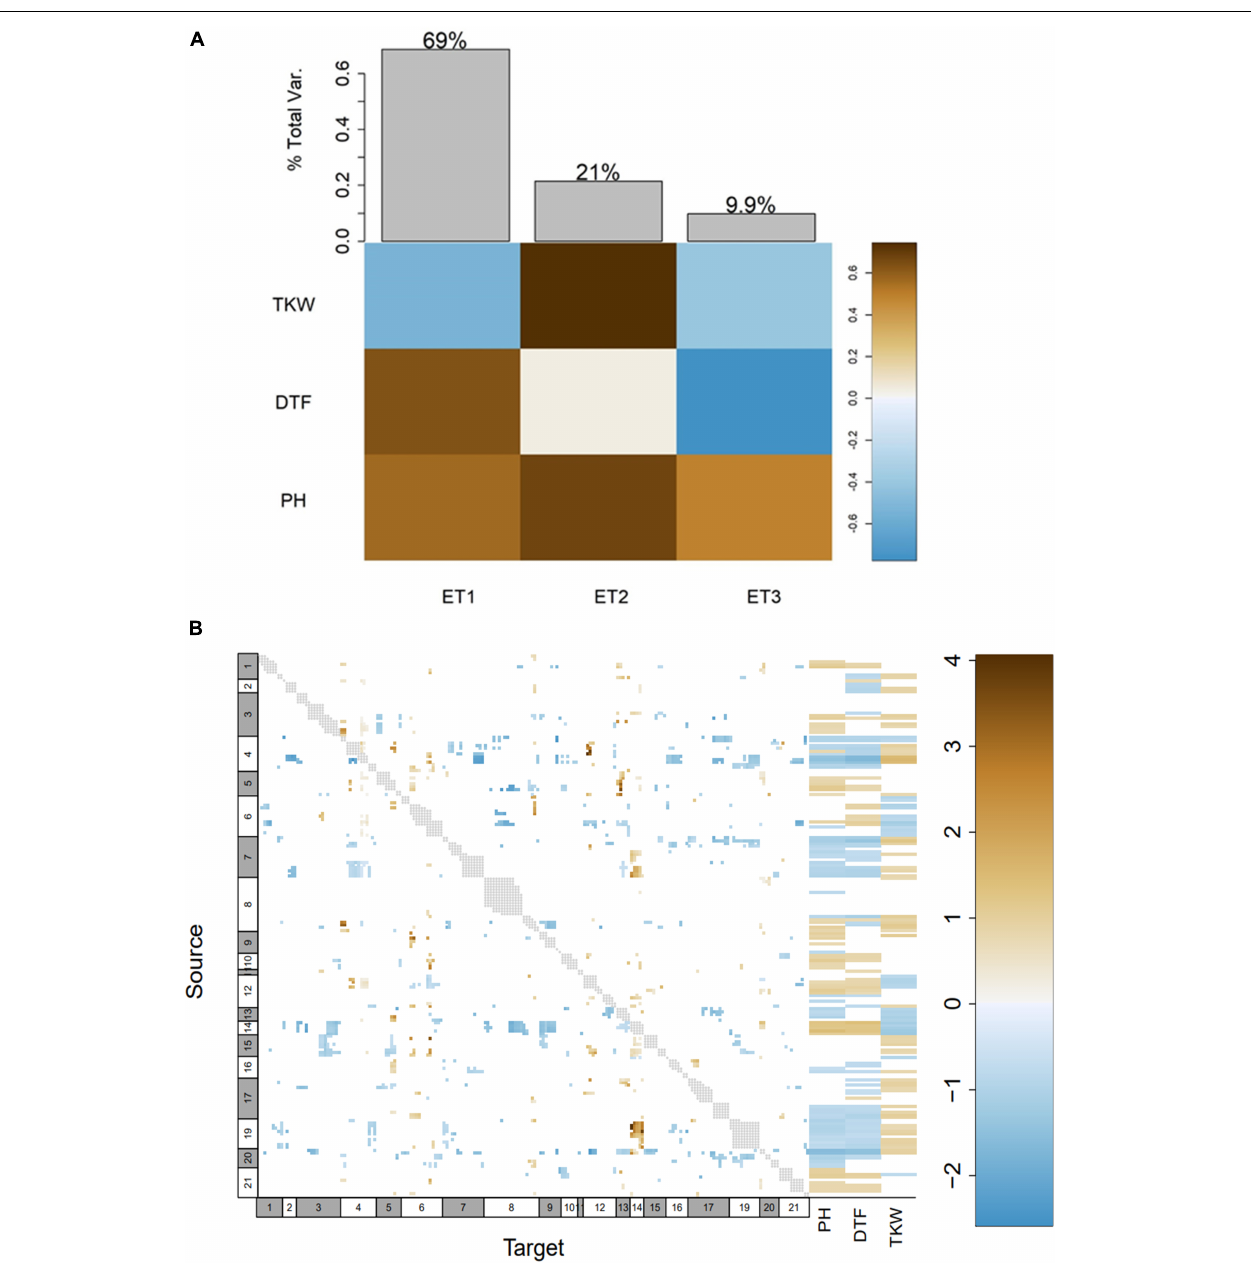
of PI-614889 alleles at pleio4.1 and pleio14.1 would